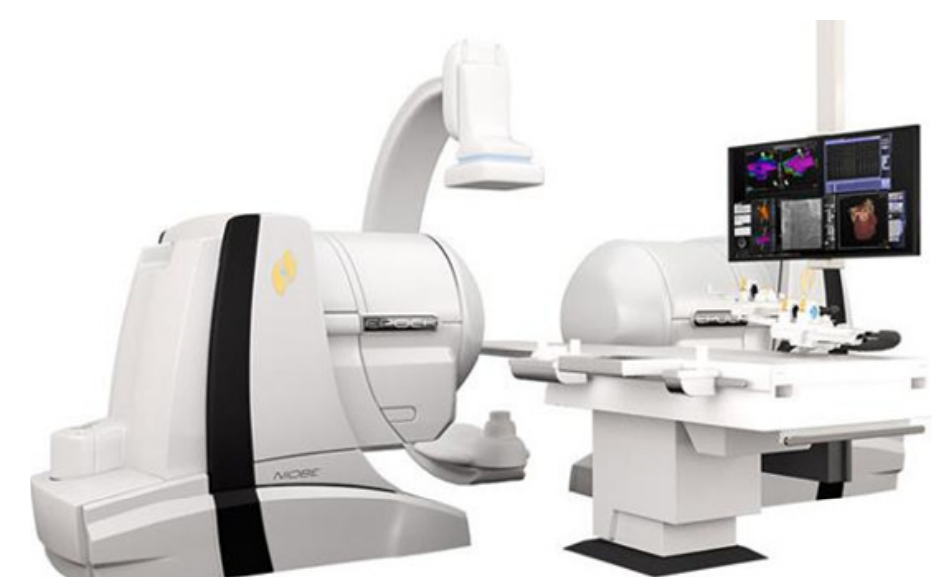
Figure 6. The Niobe robot system (Stereotaxis, St. Louis, MO, USA; copyright is owned by Stereo- taxis).